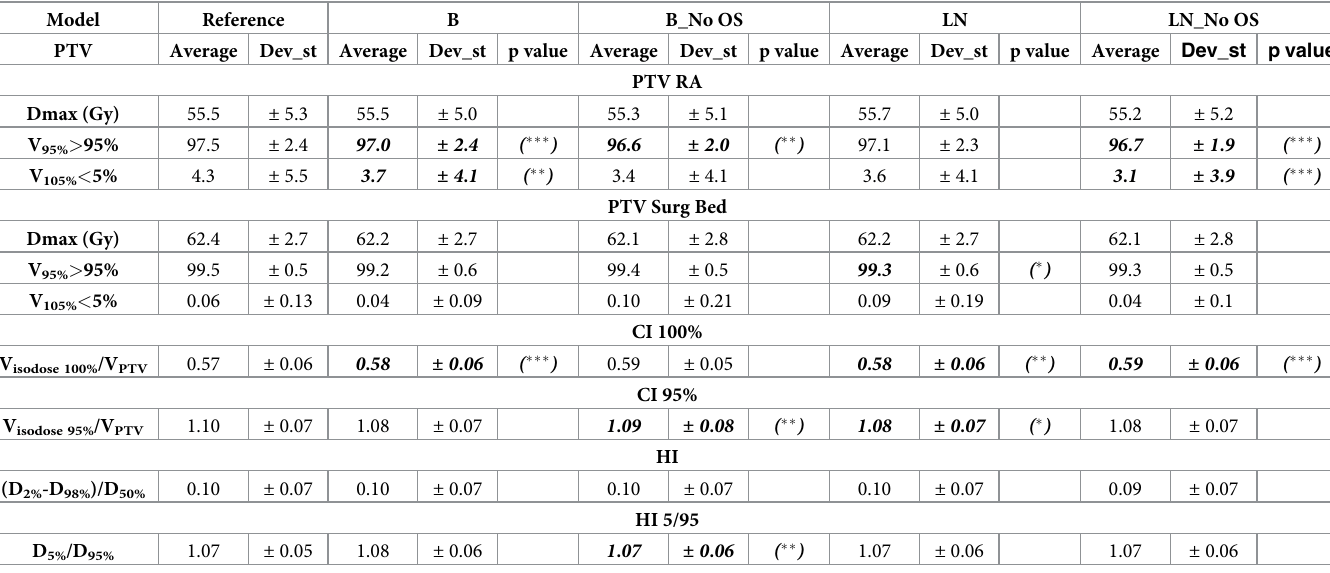
P value is reported with � , �� or ��� when significant as explained in the